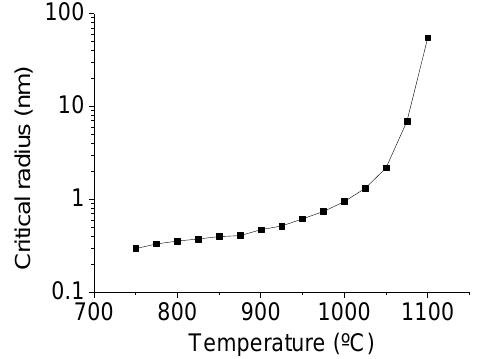
Figure 3. Critical radius size vs. temperature for VCN precipitates.